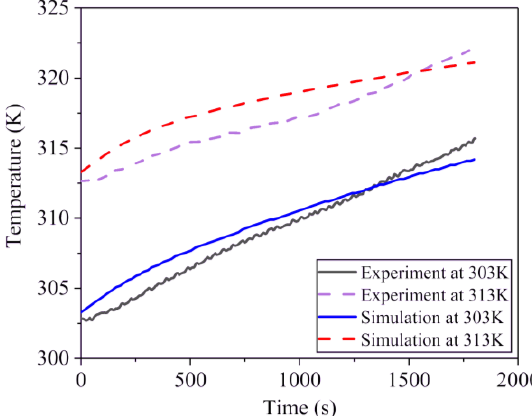
Figure 15. Experimental and simulated temperature rise curves of the battery pack.